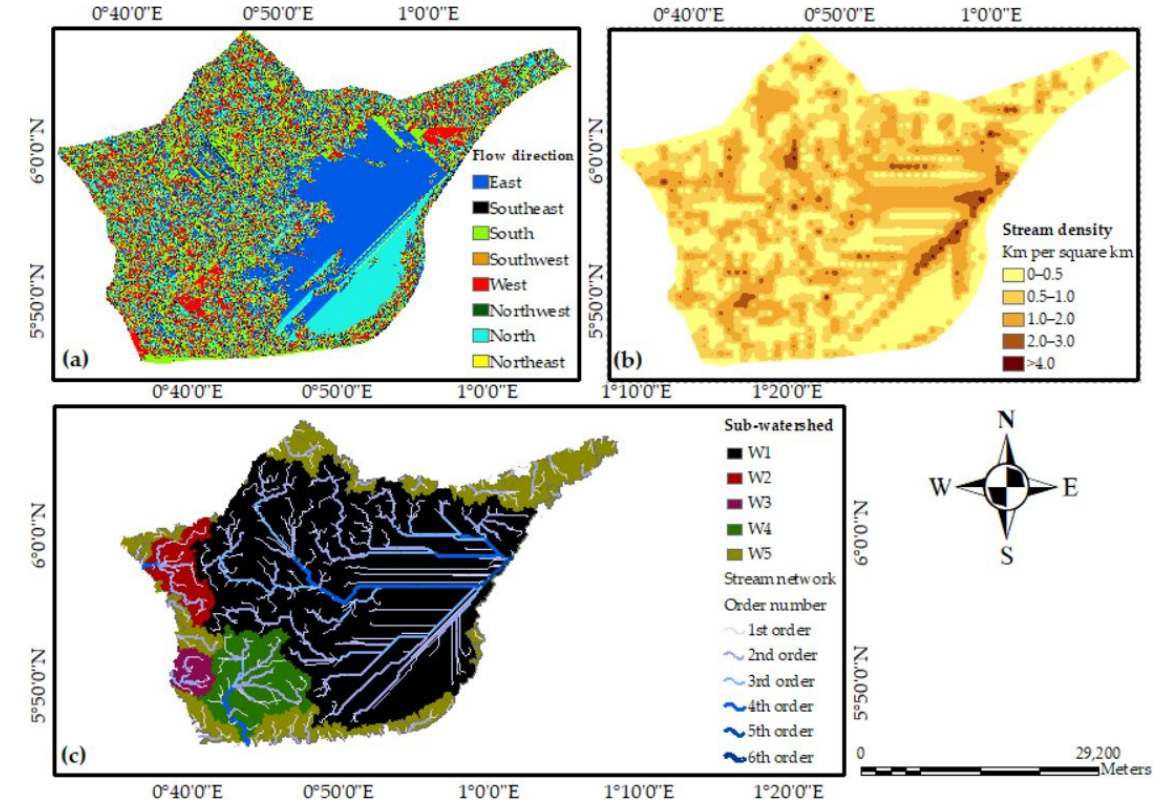
Figure 8. ( a ) Flow direction, ( b ) stream density map, and ( c ) stream network and sub-watershed.